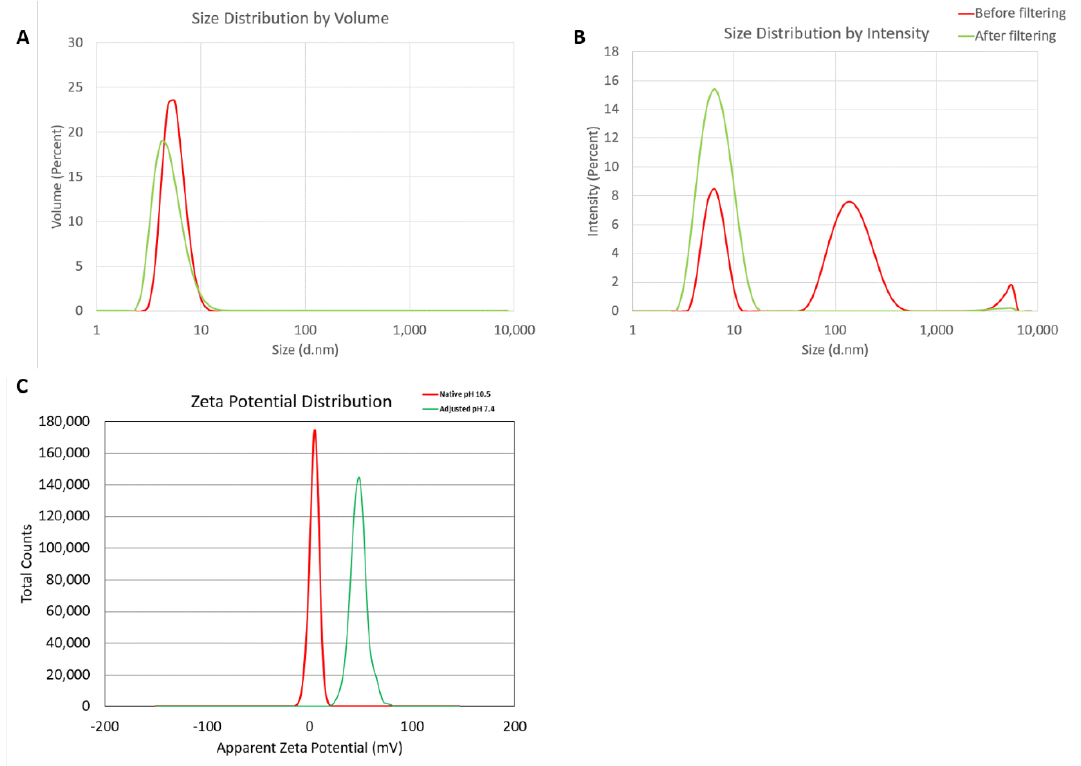
Figure 1. Physicochemical characterization of the G5-NH 2 PAMAM dendrimers. The averaged intensity ( A ) and volume ( B ) distribution plots as measured by dynamic light scattering and the averaged zeta potential distribution ( C ). The hydrodynamic size was measured before and after filtration through a 0.02 µm filter. Zeta potential was measured both at its native pH and after adjustment to neutrality. Table 1. Summary of the hydrodynamic diameters for G5-NH 2 PAMAM dendrimers. Sample